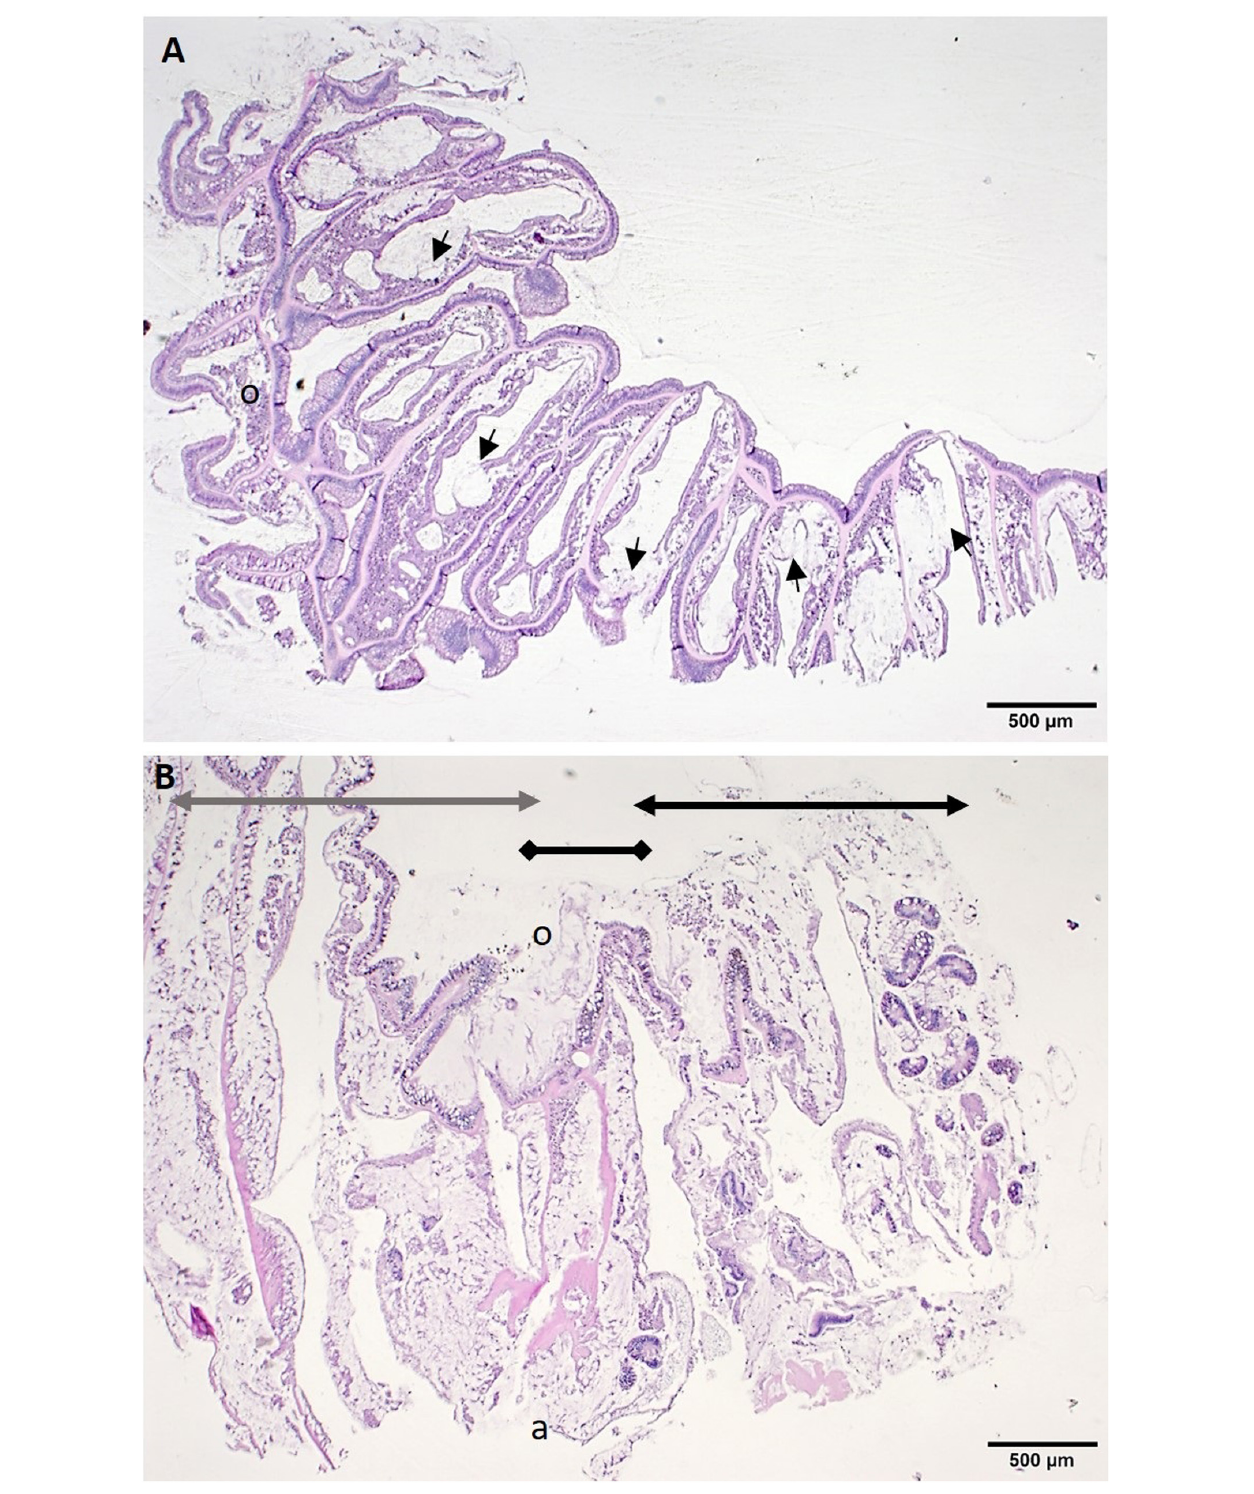
FIGURE 5 | Low magnification of histological sections of tissue-loss area. (A) Radial section through half a polyp along the septa of Montastraea cavernosa showing lesions adjacent to the skeleton in the basal body wall (BBW). Note foci of lytic necrosis (LN) in the BBW (arrows). (B) Sagittal section through tissue-loss boundary area in Pseudodiploria strigosa showing extensive coagulative necrosis including sloughed surface epidermis (black double-arrow line), lesion margin (black double-diamond line) and apparently healthy tissue zone (gray double-arrow line). H and E, o = oral region, a = aboral region.